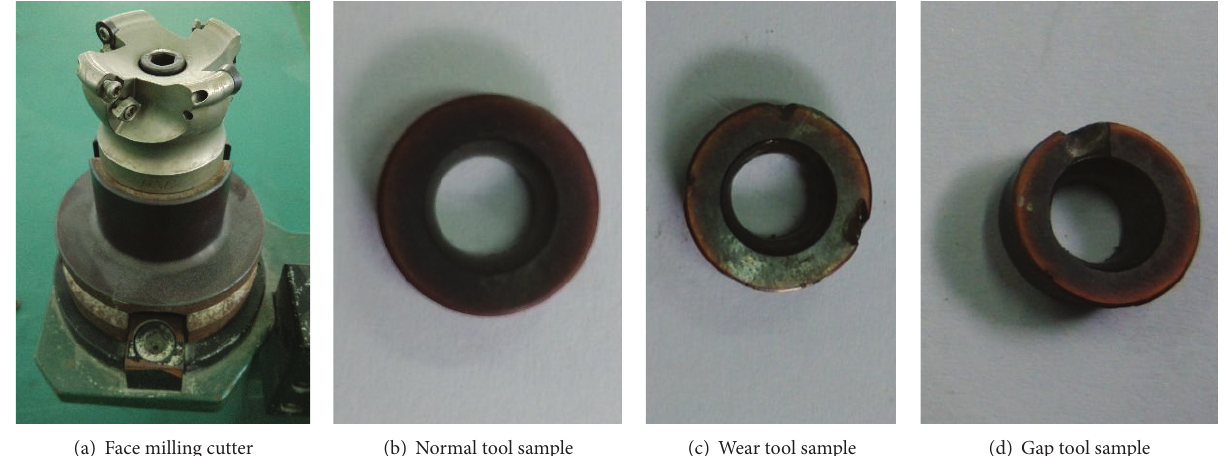
Figure 3: Samples of milling cutter shape and different tools.